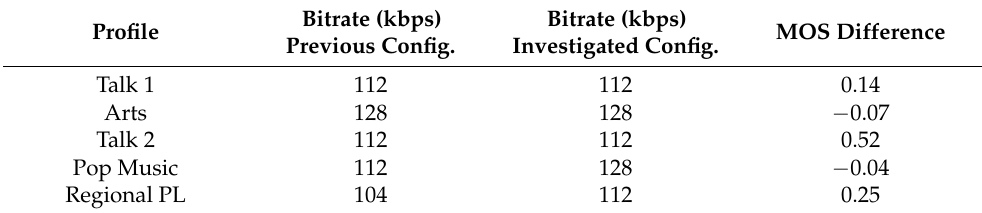
Table 8. Difference in subjective MOS judgements of DAB+ radio programs—previous and investi- gated multiplex ensemble